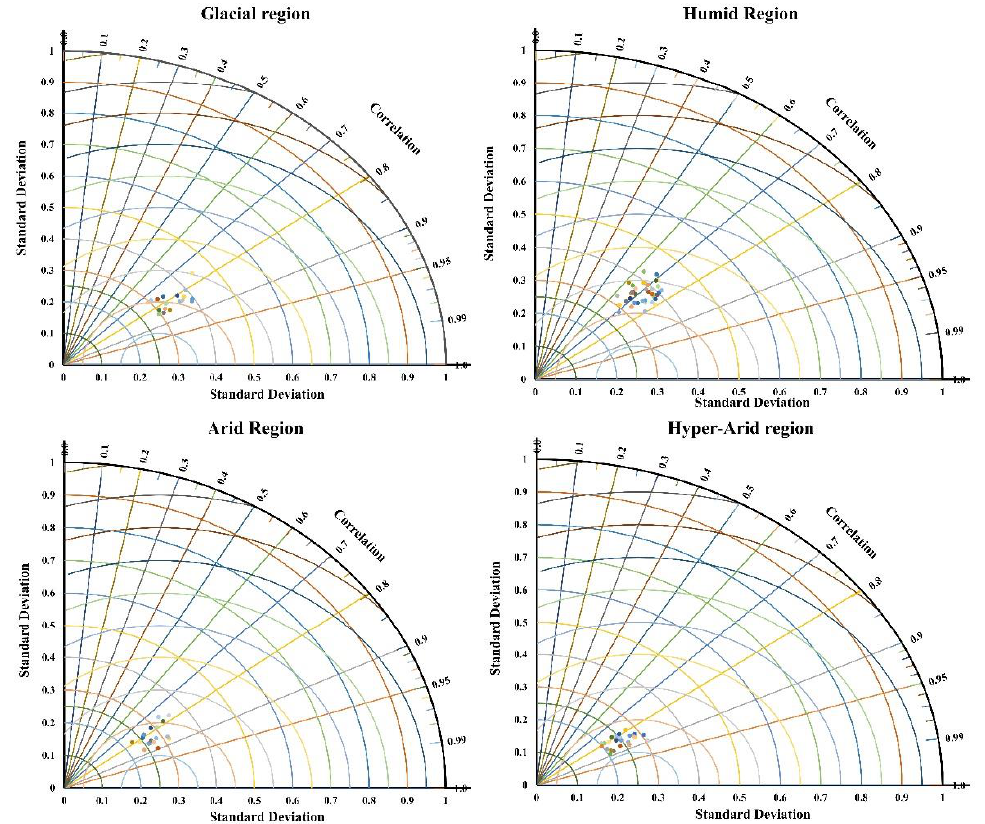
Figure 10. Taylor diagram shows the spatial variability of SPI-3 time-series of RWALS-MPSD against every RG in each climate region.